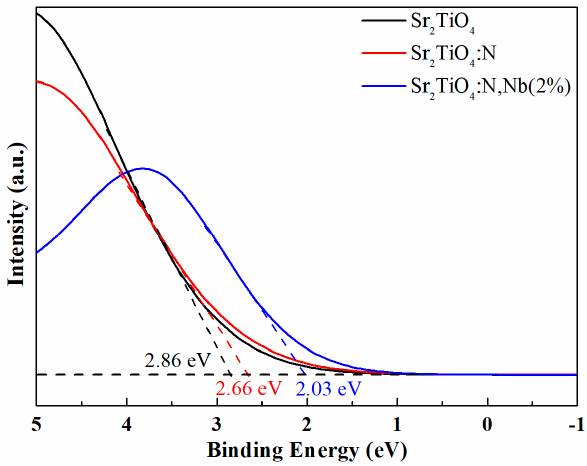
Figure 11. XPS valence band spectra of Sr 2 TiO 4 , Sr 2 TiO 4 :N, and Sr 2 TiO 4 :N,Nb(2%).